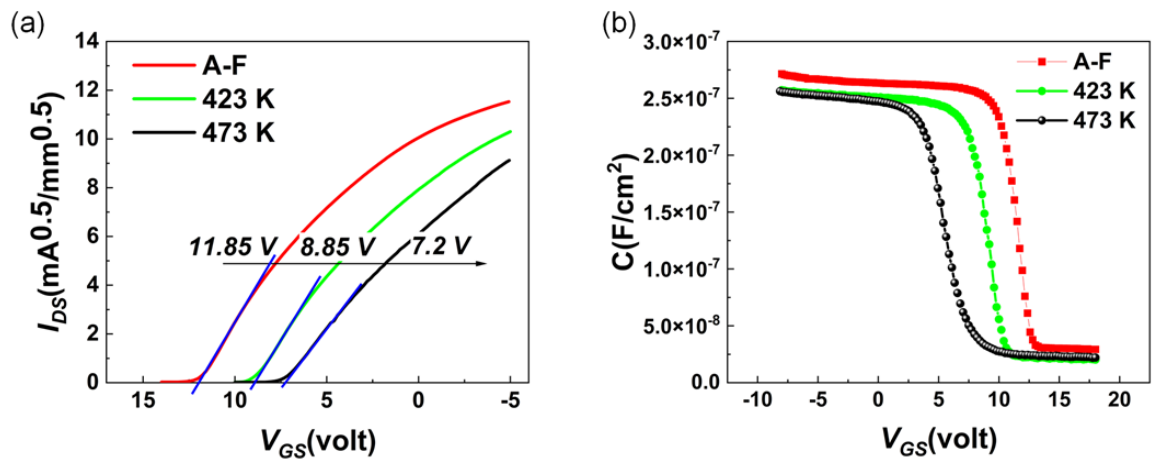
Figure 5. ( a ) transfer curve of MOSFET as-fabricated(A-F) and after annealing process at 423 K and 473 K for 3 min ( b ) C-V curve of MOSFET as-fabricated(A-F) and after annealing 150 °C and 200 °C process for 3 min.